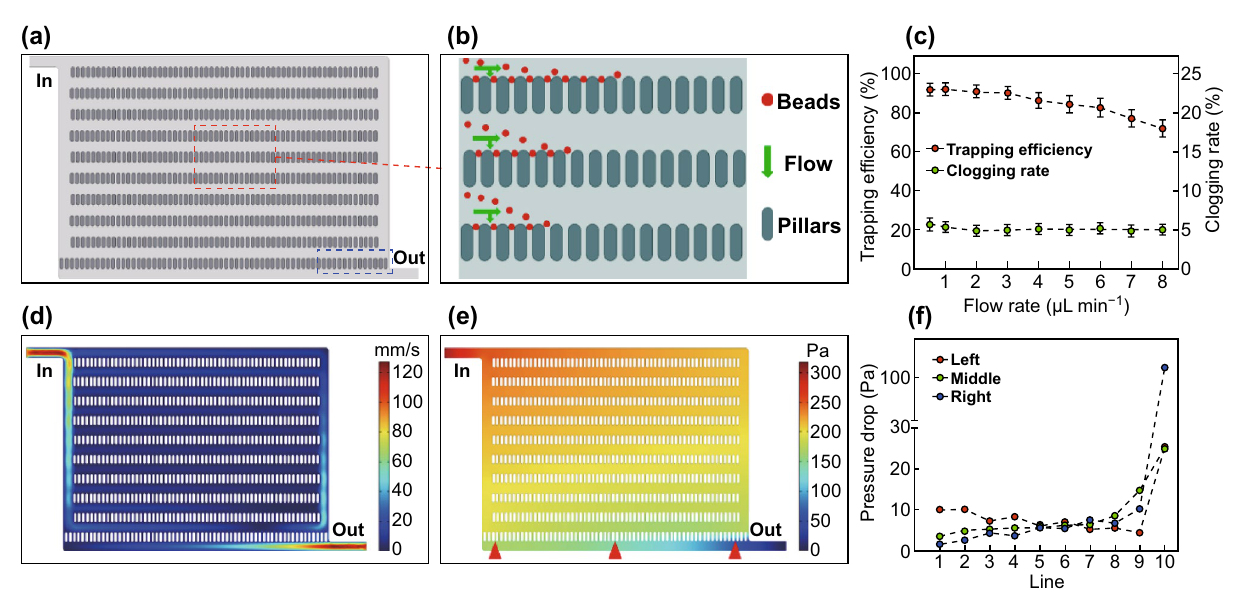
Fig. 2 Working principle and simulation of the chip. a Two-dimensional structure of the microarray. The control district is labeled by the blue dashed box. b Schematic diagram of beads trapped at gaps along the microarray. c Influence of flow rate on trapping efficiency and clogging rate. d Flow velocity profile and e pressure profile of the fluid dynamics in the chip using a velocity of 88 mm s −1 at the inlet. f The variation of pressure drop at the left, middle, and right gaps from lines one to ten according to point evaluation. (Color figure